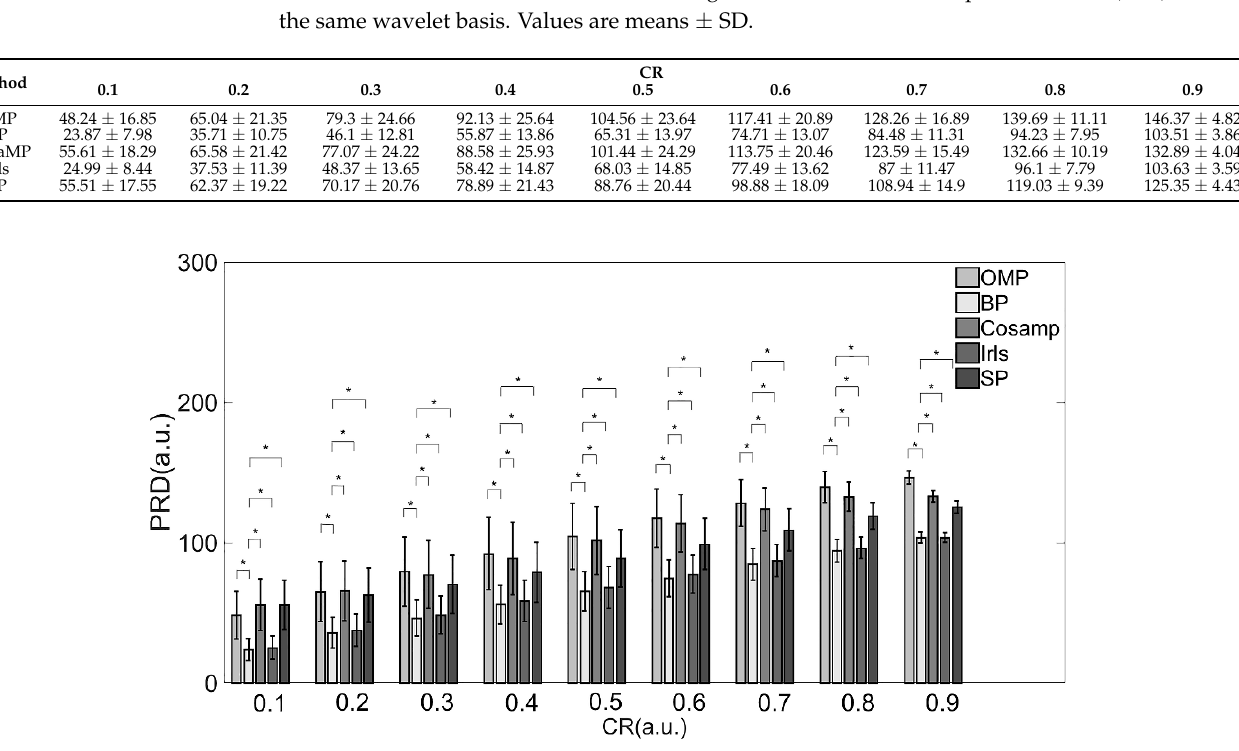
Figure 4. Execution times of various reconstruction algorithms. Note: * Indicates statistical significance via two-sample t -tests. Table 3. Execution times (in seconds) of various reconstruction algorithms. Values are mean ± SD. Method